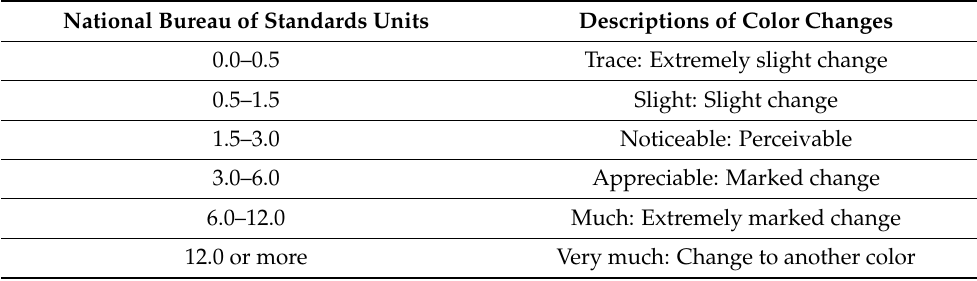
Table 1. National Bureau of Standard